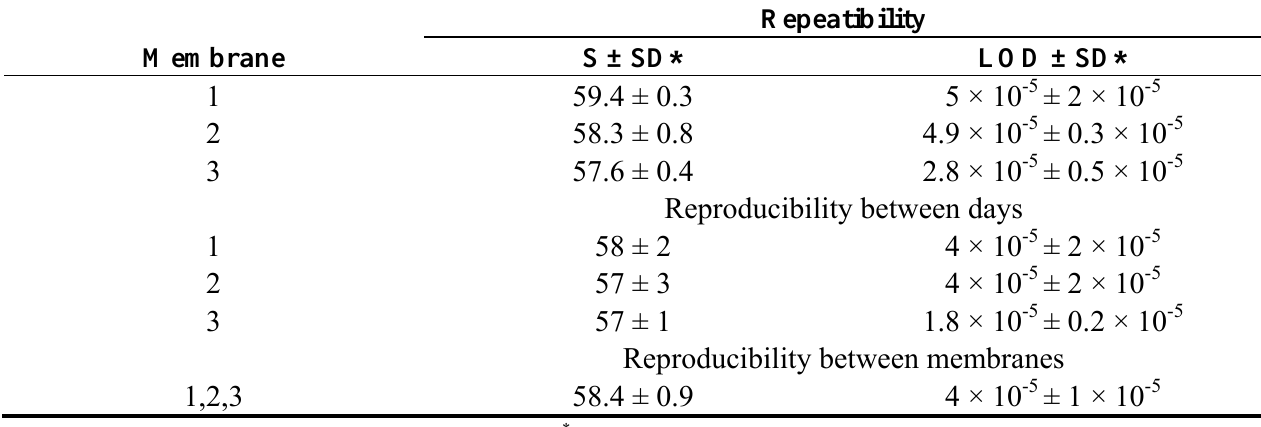
Table 3. Repeatability and reproducibility of sulpiride electrode.